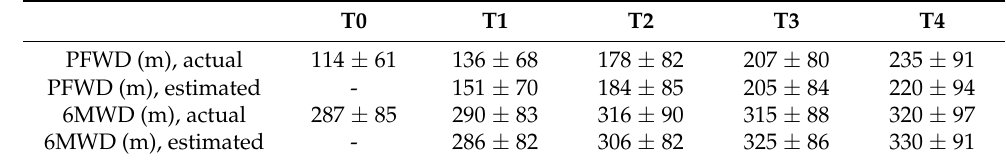
Table 3. Actual and estimated values of performance over the four time